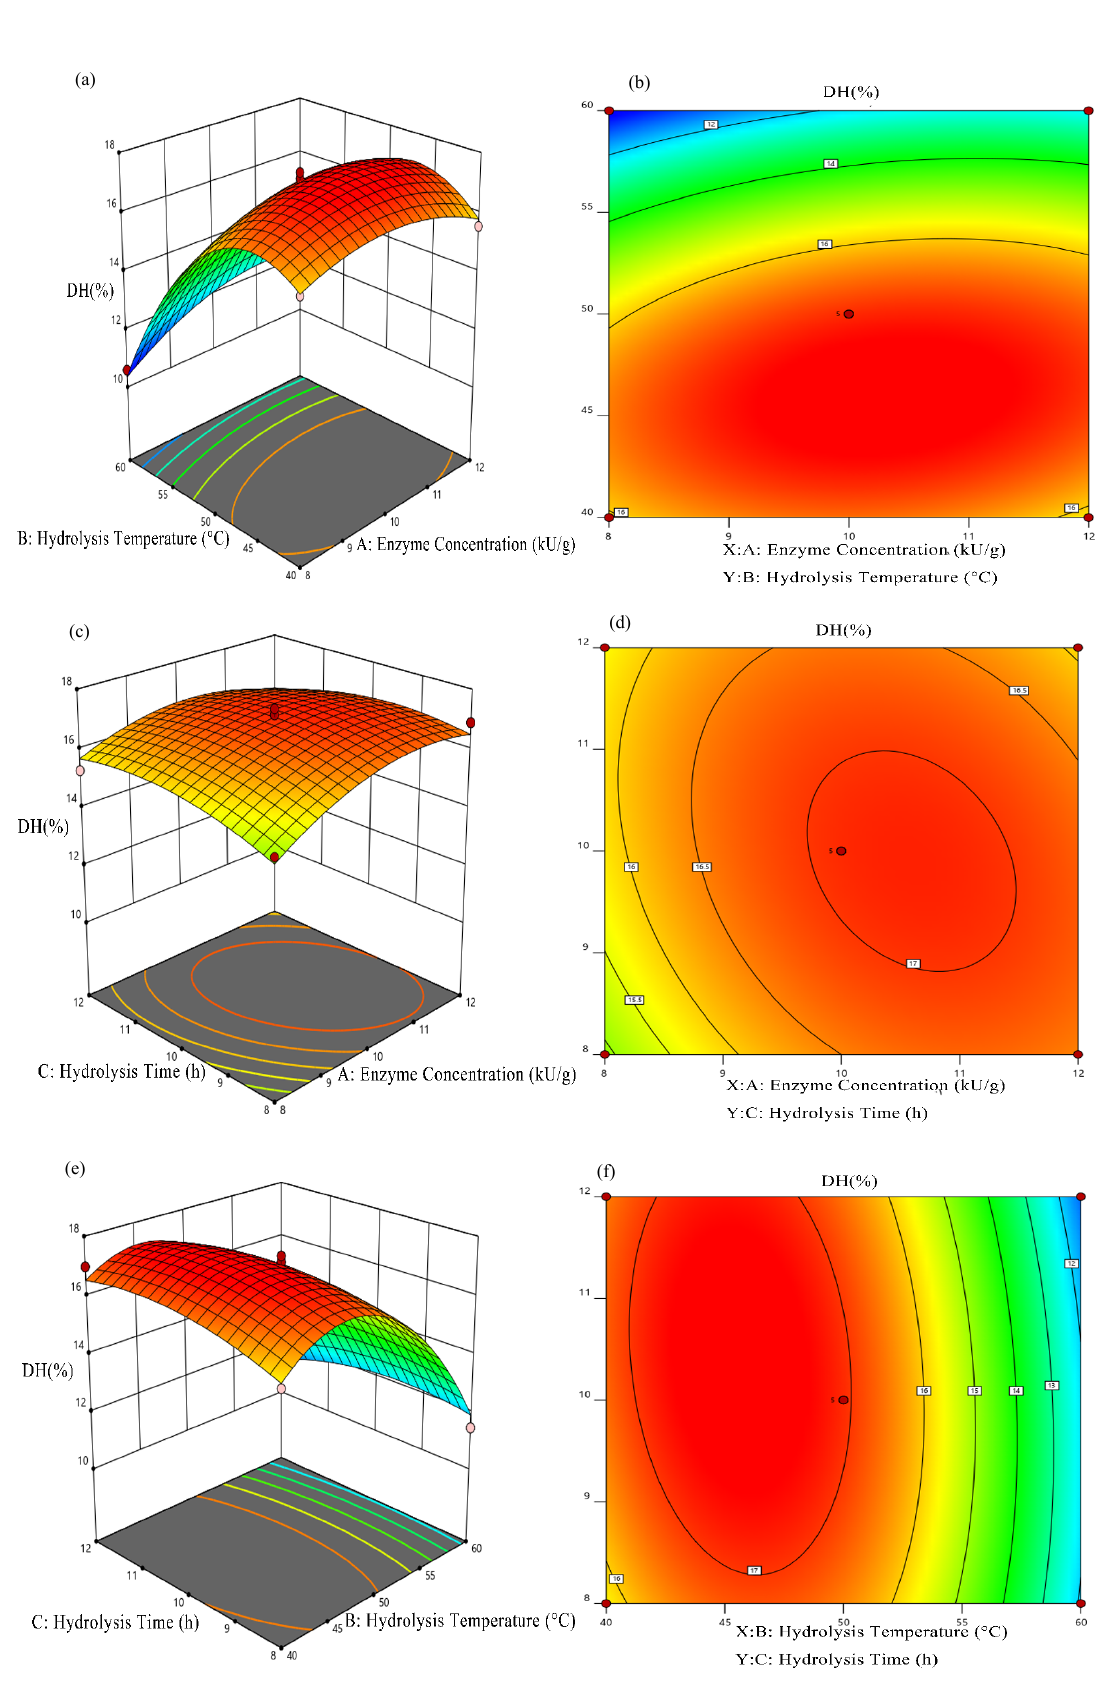
Figure 3. Responsive surface plots and corresponding contour plots of DH of BENH. Interaction of enzyme concentration and hydrolysis temperature ( a , b ). Interaction of enzyme concentration and hydrolysis time ( c , d ). Interaction of hydrolysis temperature and hydrolysis time ( e , f ).